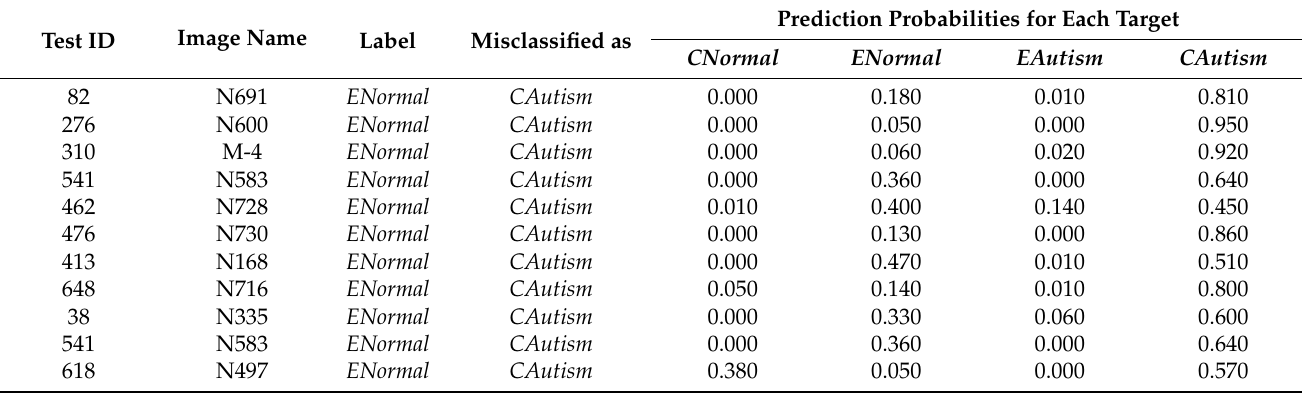
Table 14. Probability distribution for the 4 targeted classes for the 11 cases where ENormal was misclassified as CAutism . Test ID Image